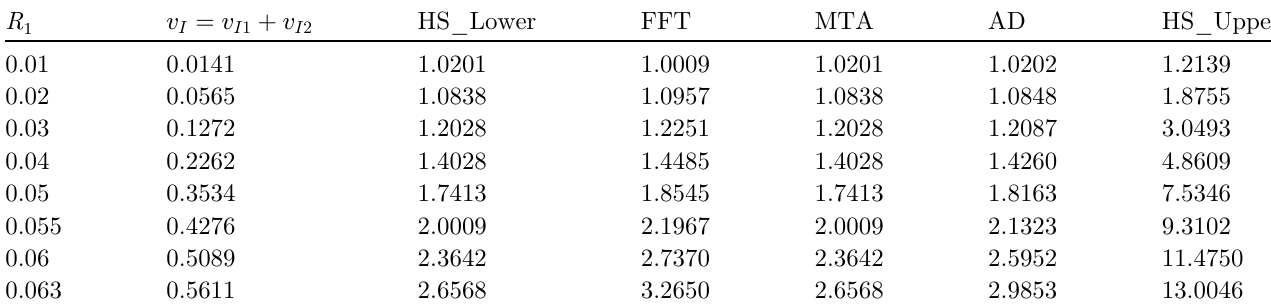
Table 2. Comparison of results ( m eff ) of FFT, MTA, DA, and HS bounds for the case (A), R 1